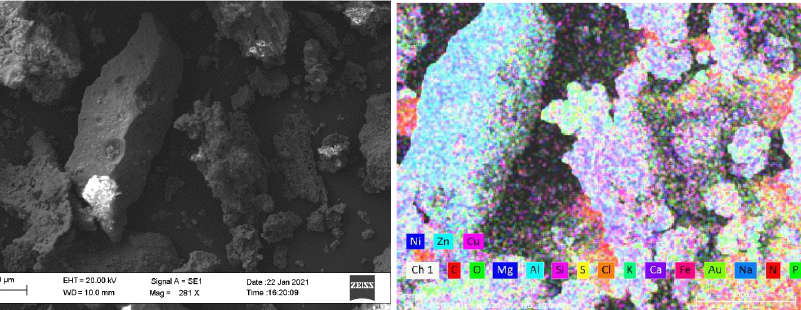
Figure 8. SEM image of ash (left), SEM-EDS scan and surface composition (right). Table 10. Surface composition of ash by means SEM-EDS.